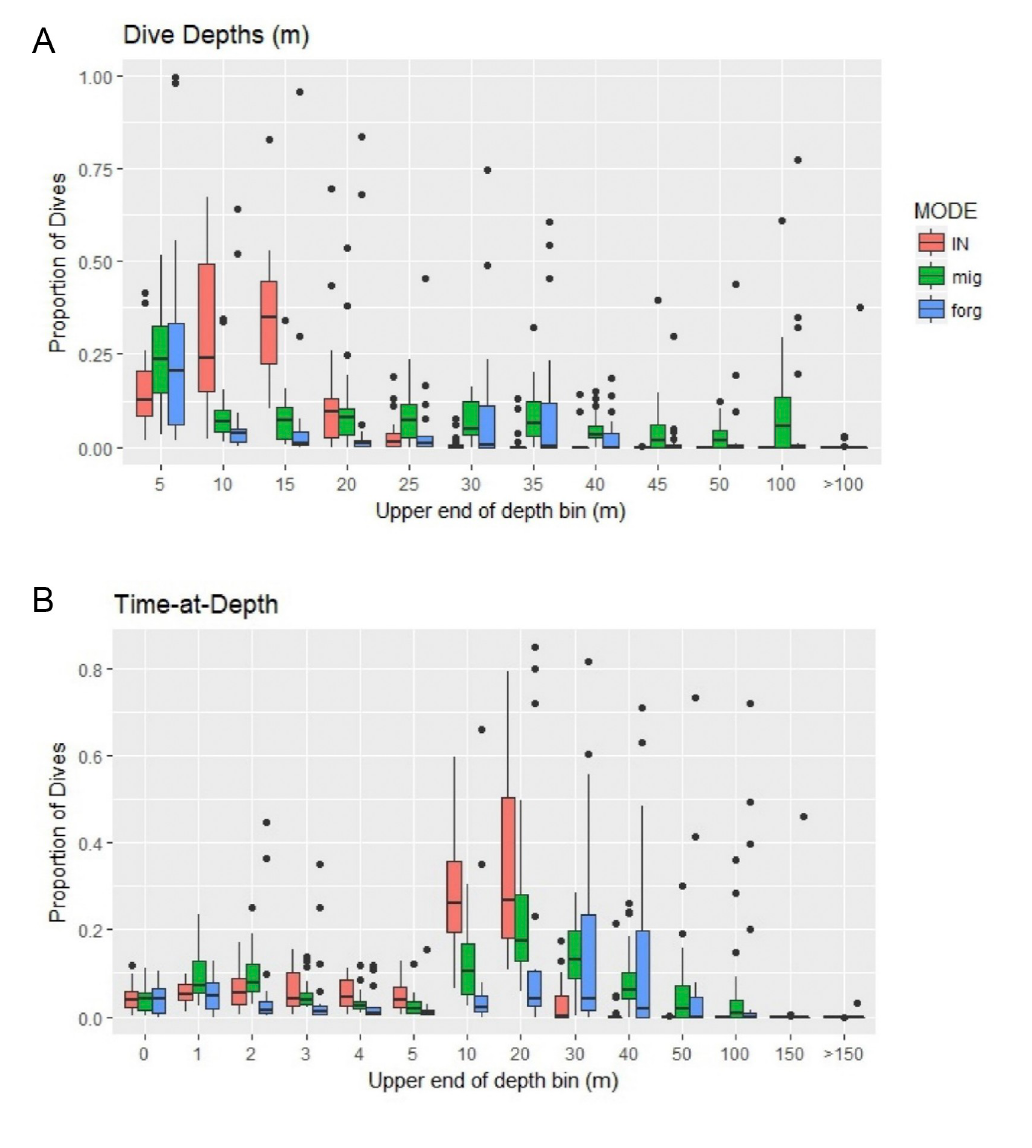
Fig 2. Boxplots for dive depth and the proportion of time-at-depth (TAD) for adult female loggerhead turtles ( Caretta caretta ) in the Gulf of Mexico. Proportions of dive depths (A) represent per turtle and per mode values with the dives per bin divided by the total dives for that mode. Values in TAD bins (B) represent the percent of time a turtle spent in a depth bin for the summary period (e.g. 24 hours). We then averaged the values per bin within dates for each behavioral mode.